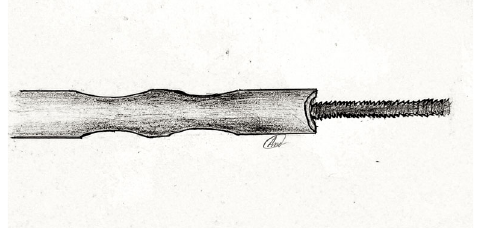
Figure 3. Threaded stainless steel extractors (3,5 mm tap).